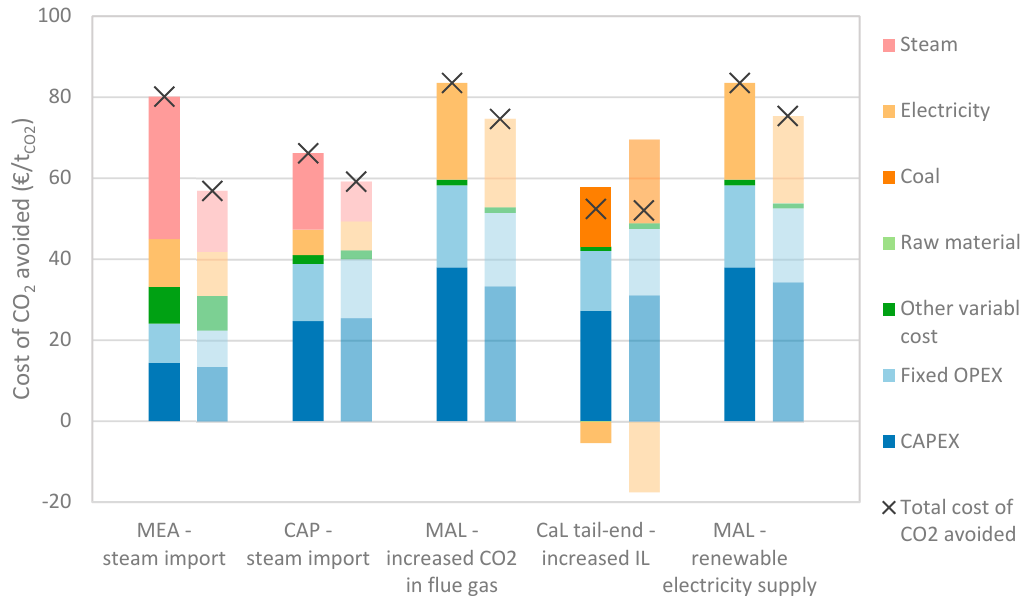
Figure 7. Cost of CO 2 avoided for alternative scenarios for CO 2 capture. The left-hand column shows the cost of CO 2 avoided calculated for the baseline scenario while the right-hand column shows the cost for the following technology-specific scenarios: MEA-steam import; CAP-steam import; MAL-increased CO 2 content in flue gases; CaL tail-end-reduced integration level.